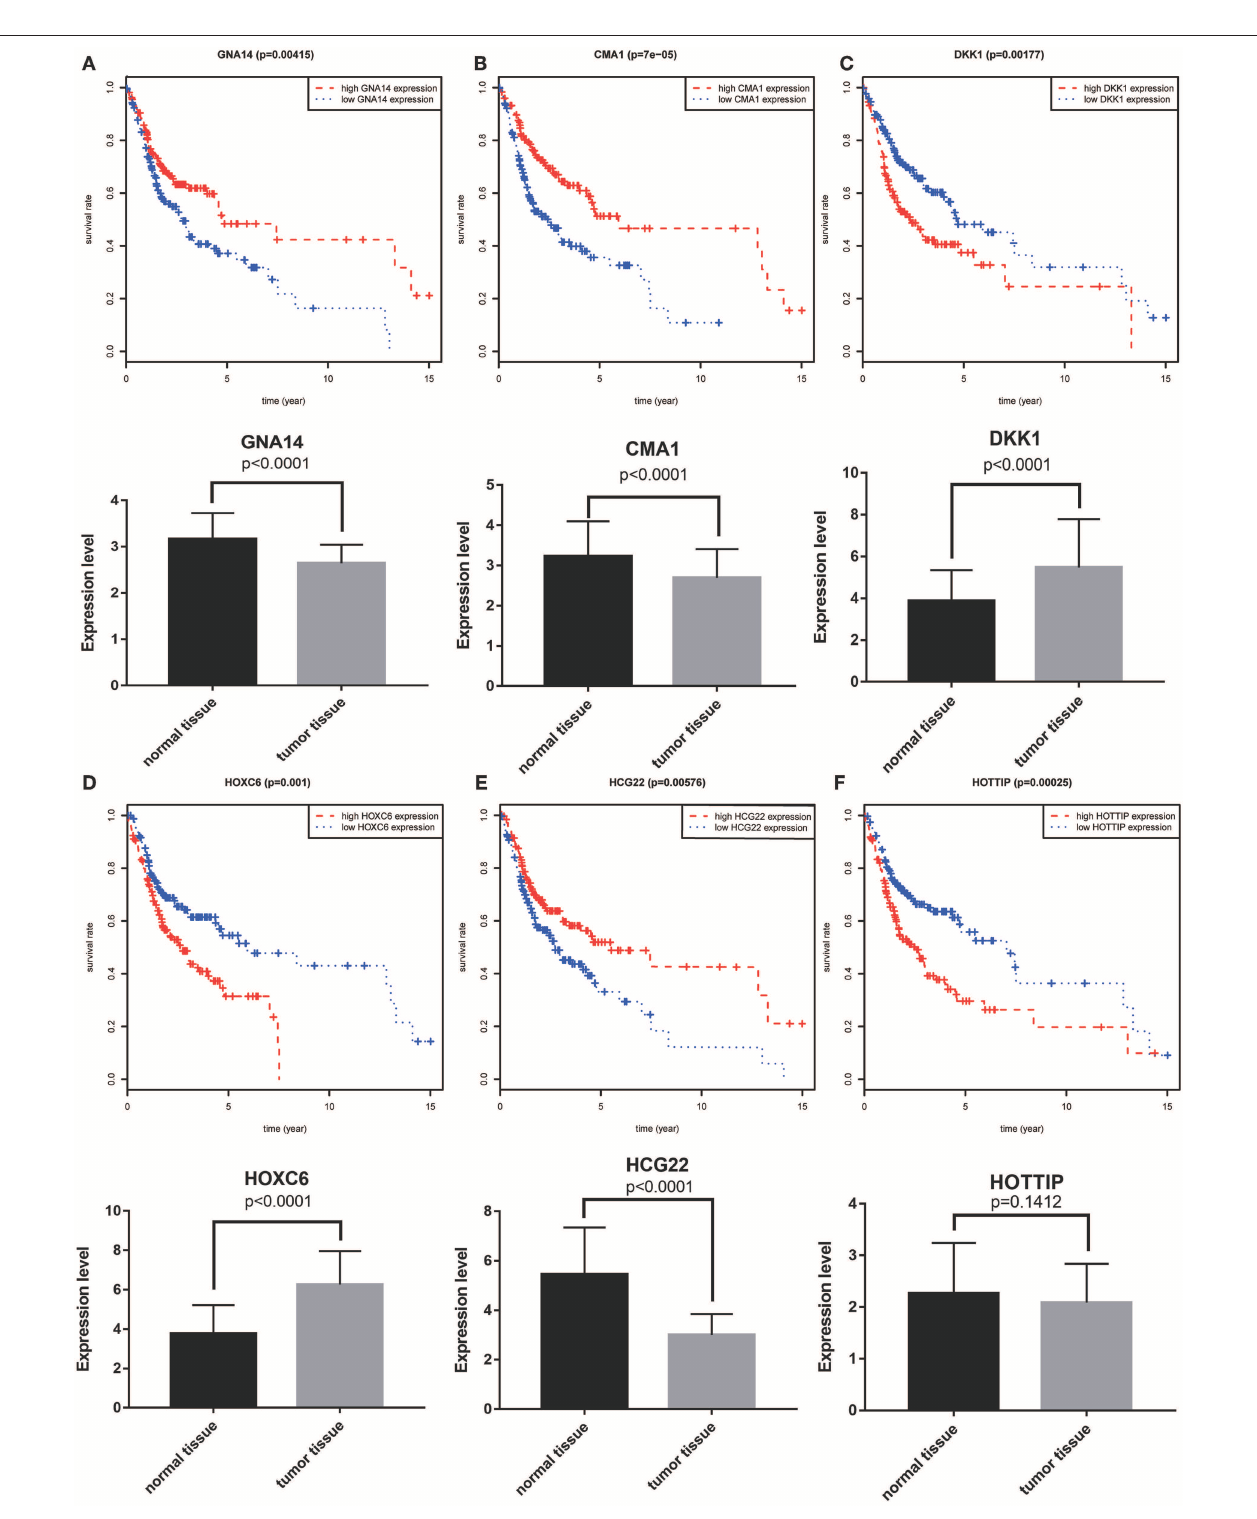
FIGURE 6 | Combining Kaplan–Meier survival analysis with univariate Cox regression to screen biomarkers in OSCC patients. Kaplan–Meier survival curves and GEO gene expression profiles for the three protective genes, GNA14 (A) , CMA1 (B) and HCG22 (C) , and risky genes DKK1 (D) , HOXC6 (E) , and HOTTIP (F) were associated with overall survival in OSCC. GNA14:G protein subunit alpha 14; CMA1:chymase 1; DKK1: dickkopf WNT signaling pathway inhibitor 1; HOXC6:homeobox C6; HOTTIP:HOXA distal transcript antisense RNA; HCG22:HLA complex group 22.